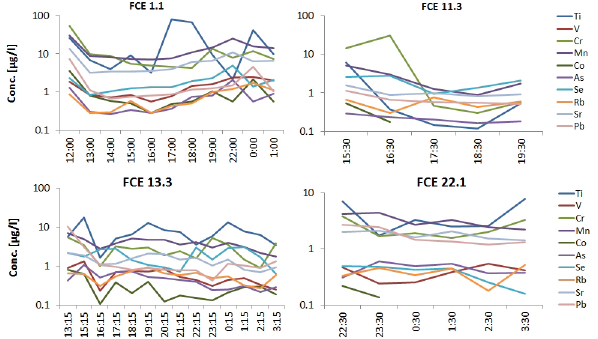
Figure 7. Temporal variation of size-resolved soluble transition metal ions, Fe(III), Fe(II), Cu(II), and Mn(II) in cloud water on 14– 15 September 2010 during FCE 1.1. The nominal stage cutoffs were 22, 16, and 4µm for St. 1, St. 2, and St. 3, respectively.